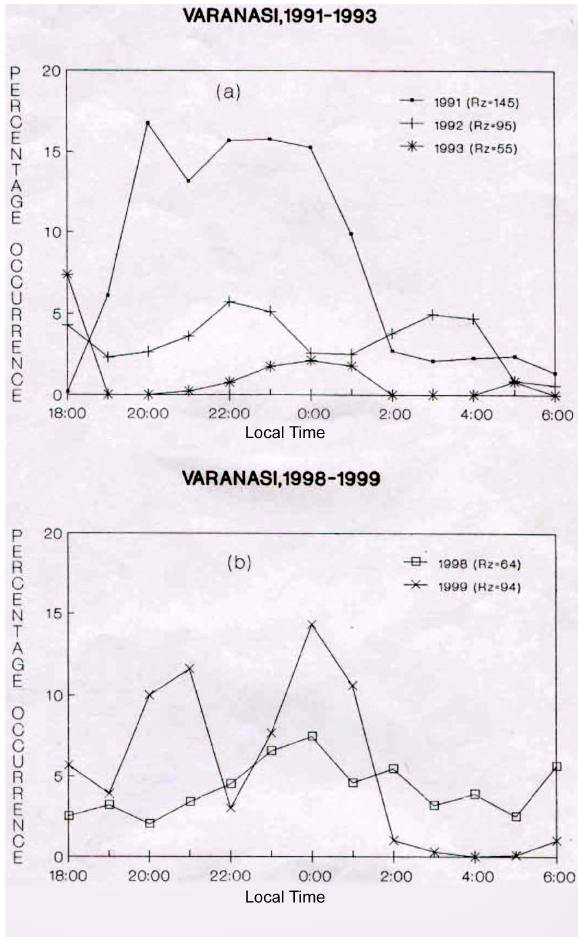
Fig. 4. The nocturnal variation of scintillation occurrence rate along with mean sun spot number as a function of time is shown (a) peak scintillation occurrence 17% during 1991 (Rz=145), 6% dur- ing 1992 (Rz=95) and 3% during 1993 (Rz=55) (b) 7.5% during 1998 (Rz=64) and 15% during 1999 (Rz=94), where Rz is mean sunspot